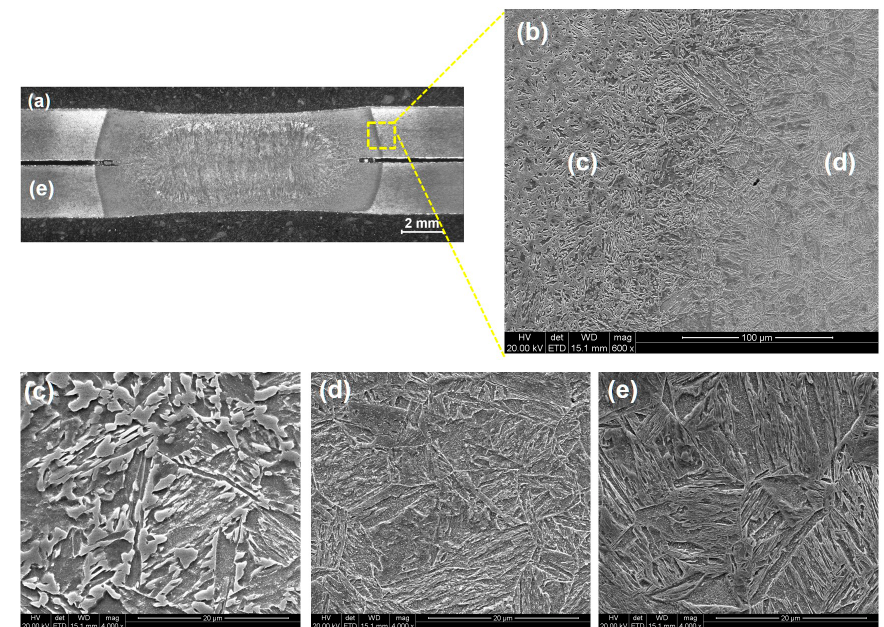
Figure 15. Cross-section characteristic of the spot welds: ( a ) overall view; ( b ) enlarged view of zone ( b ) in ( a ); ( c ) enlarged view of softening zone ( c ) in ( b ); ( d ) enlarged view of softening zone ( d ) in ( b ); ( e ) enlarged view of base metal zone.